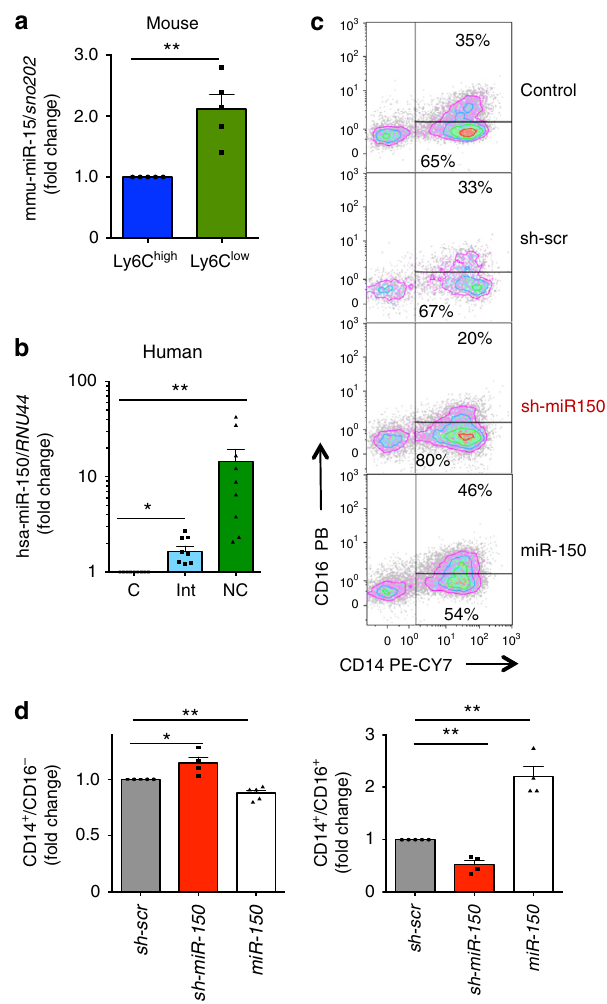
Fig. 4 Differential expression of miR-150 in human and mouse monocyte subsets. a qRT-PCR analysis of mmu-miR-150 expression normalized to sno202 in Ly6C low compared to Ly6C high monocytes sorted from wild-type mice peripheral blood. Results are expressed as fold-change relative to Ly6C high monocytes. Mean ± SEM of fi ve independent experiments, paired t test, ** P < 0.01. b qRT-PCR analysis of hsa-miR-150 expression normalized to RNU-44 in peripheral blood classical (C), intermediate (Int), and nonclassical (NC) monocytes sorted from peripheral blood samples of nine healthy donor controls. Results are expressed as fold-change relative to classical monocytes. Mean ± SEM; paired t test, * P < 0.05; ** P < 0.01. c , d Sorted CD34 + cells were not transduced (control) or transduced with vectors expressing the GFP and a control shRNA (Sh-SCR) or a shRNA targeting hsa-miR-150 (sh-miR-150) or hsa-miR-150 (miR-150), and then cultured in liquid medium for 7 days in the presence of SCF and M-CSF before fl ow cytometry analysis of generated monocyte subsets, based on CD14 and CD16 expression. c shows a representative fl ow cytometry analysis. d shows the fraction of CD14 + CD16 − (left panel) and CD14 + CD16 + (right panel) generated by CD34 + cells with decreased (sh-miR-150) or increased (miR-150) hsa-miR-150 level relative to controls (sh-scr). Mean ± SEM of four independent experiments, paired t test, * P < 0.05; ** P <